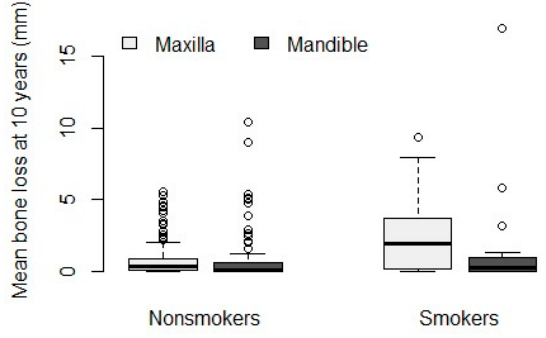
Figure 6. Boxplot reporting on individual peri-implant bone loss in smokers and non-smokers after a minimum of 10 years, comparing upper and lower jaw.